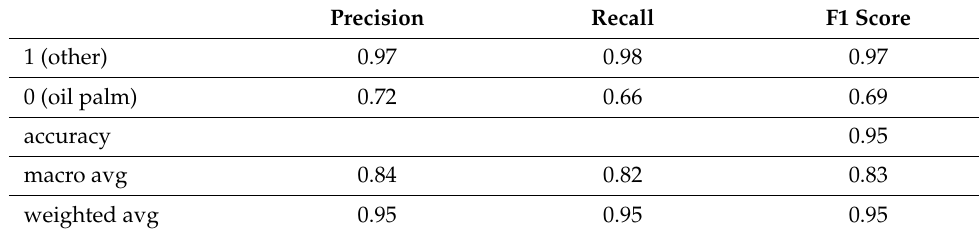
Table 3. Results of our training model for deforestation prediction. Precision Recall F1